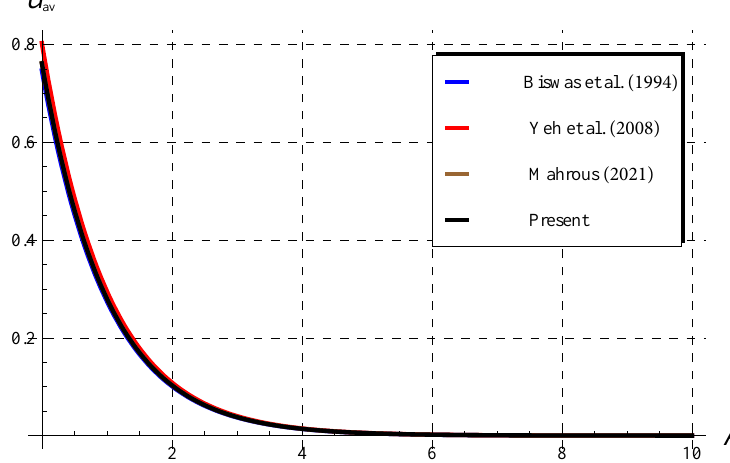
Figure 8. Comparisons between the present cup-mixing average concentration u av and the corre- sponding ones in literature as α → 1 when A 0 = 1.4 and A 2 = 0.1